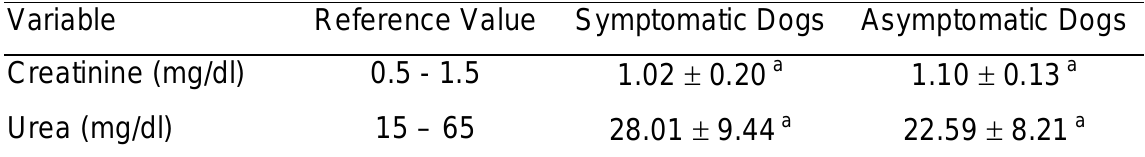
Table 3: Mean and standard deviations of serum creatinine and urea in symptomatic (n=32) and asymptomatic (n=17) nonazotemic VL seropositive dogs from Teresina, Piauí State, Brazil,